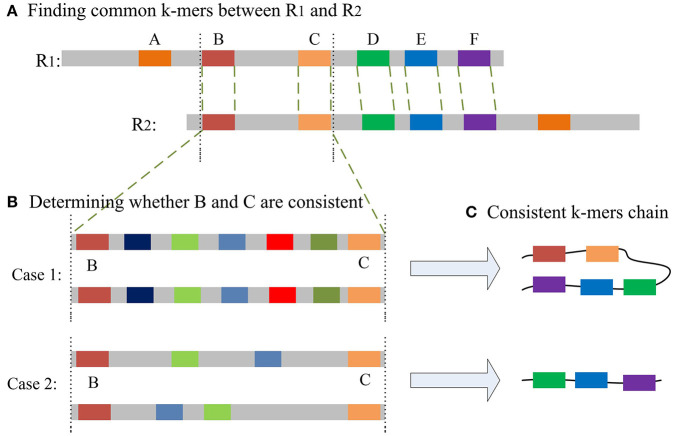
(A) A–F are the common k-mers in the two long reads, D–F is the common consistent k-mer that can be judged in the first stage. The distance between B and C is slightly longer, but less than β. (B) Aligning sequences between B and C with smaller ks-mers in the second stage may result in two situations. Case 1: Multiple ks-mers can be compared between B and C; Case2: there are no common consistent ks-mers between B and C. (C) According to different situations, two different consistent chains will be generated.